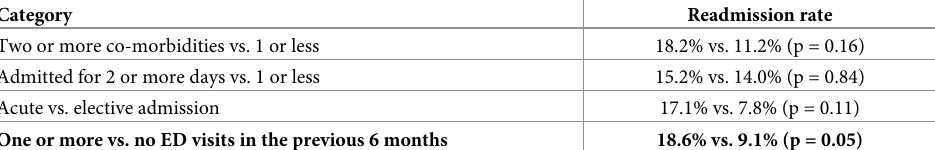
Table 2. Risk of readmission associated with increased co-morbidity, acuity of admission and previous number of emergency department visits.